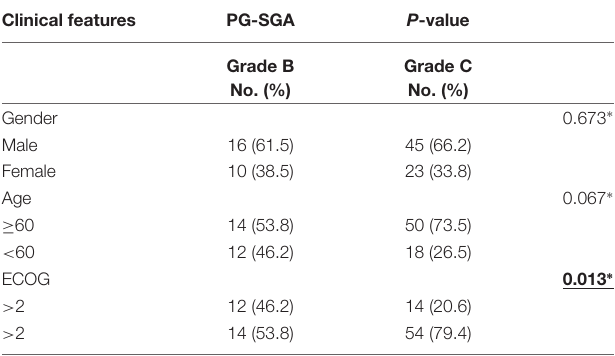
TABLE 3 | Relationship between clinical Features and